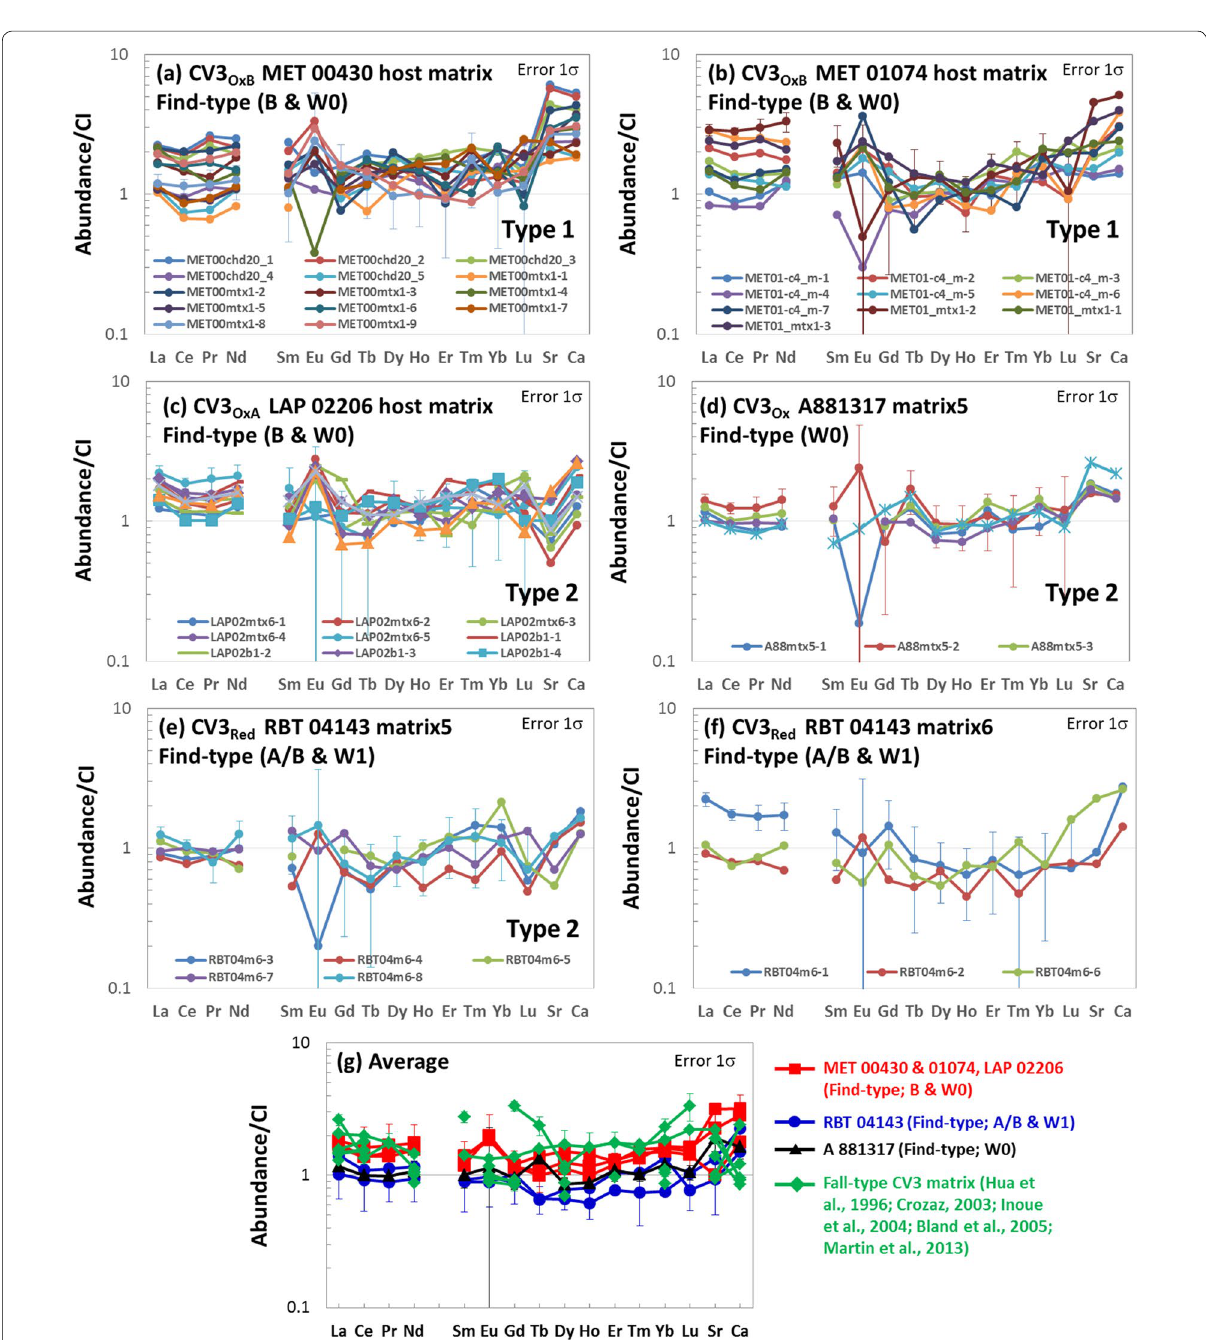
Fig. 2 CI-normalized REE, Sr and Ca abundances of CV3 matrices ( a – f ). Representative error bars (1 σ ) are shown in each matrix. Average composi- tions of find-type CV3 matrices [weathering grades of B and W0 (red), A/B and W1 (blue) and W0 (black)] and fall-type CV3 matrices (green) are shown in ( g